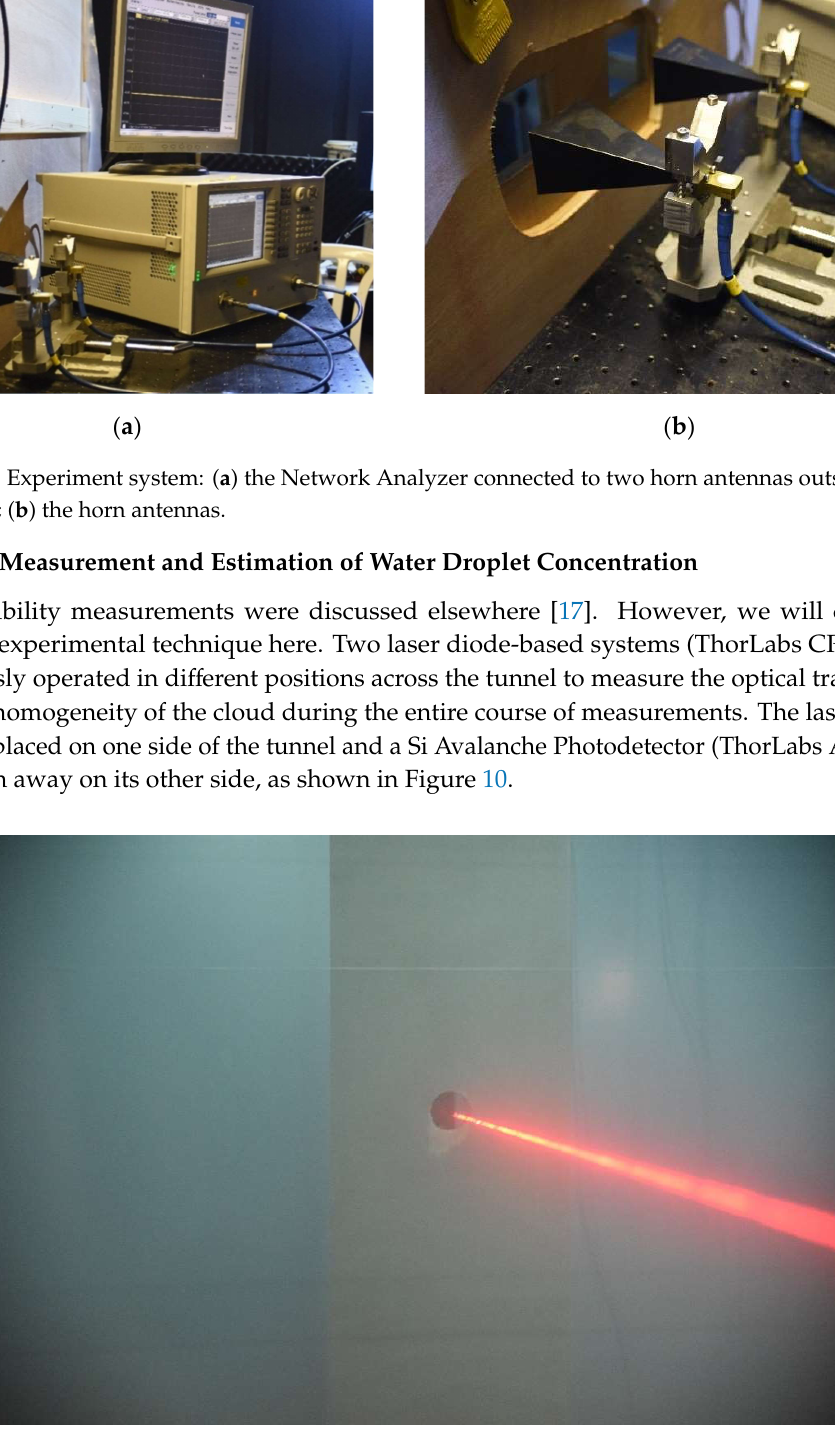
Figure 10. The laser beam passing through the fog tunnel.